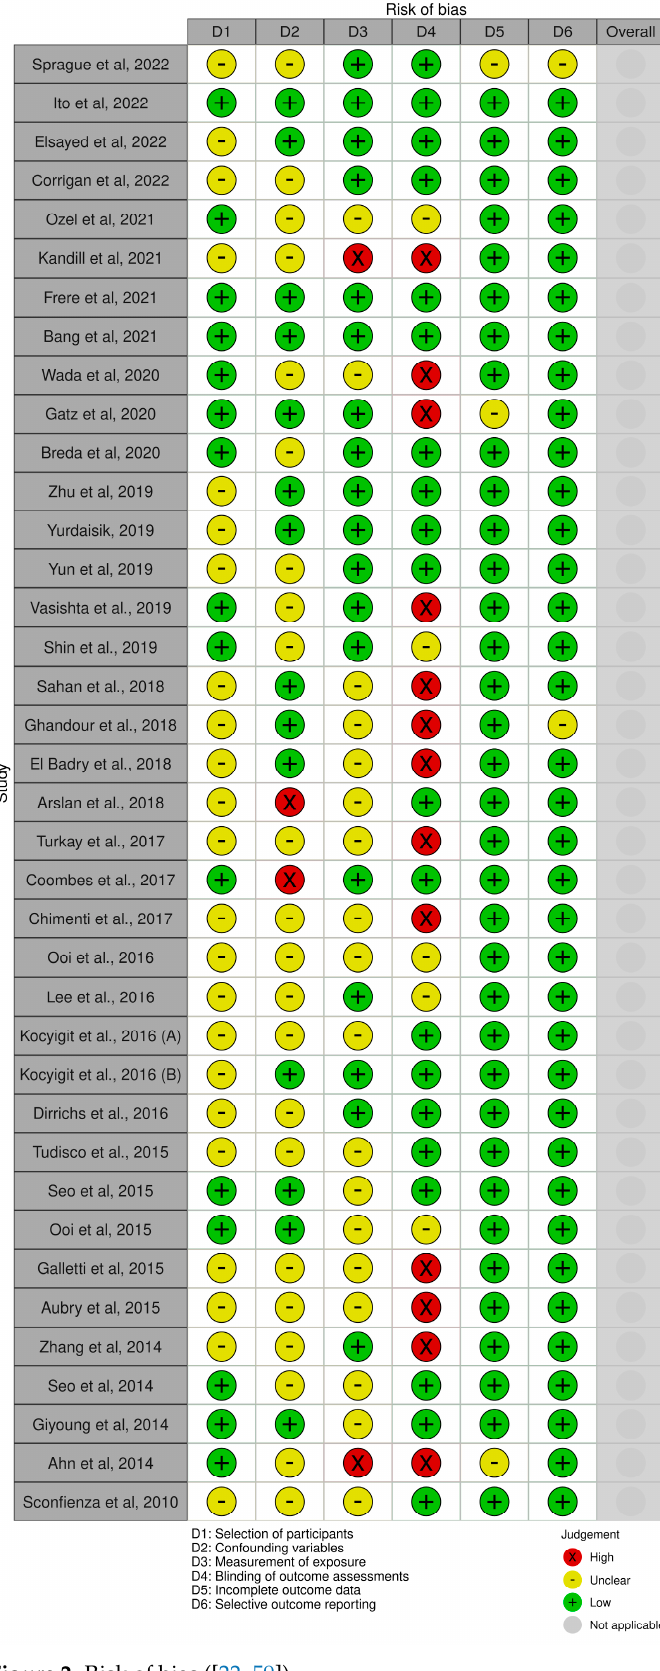
Figure 2. Risk of bias